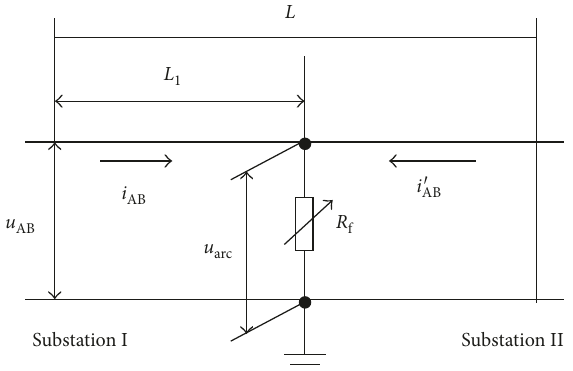
Figure 1: Equivalent circuit for the case of the two-phase (A-B) short